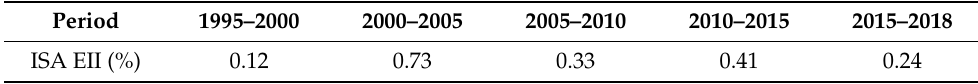
Table 4. ISA Expansion Intensity Index from 1995 to 2018.